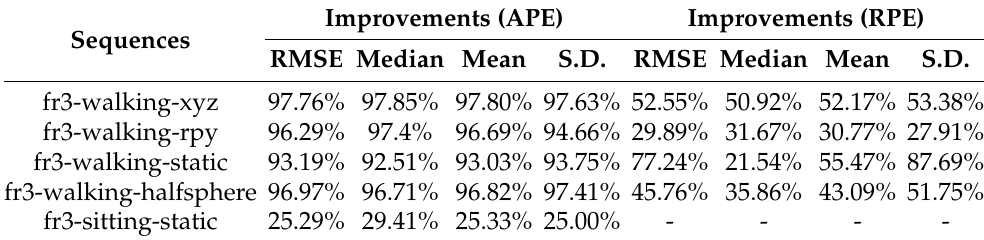
Table 3. Percentage of APE and RPE